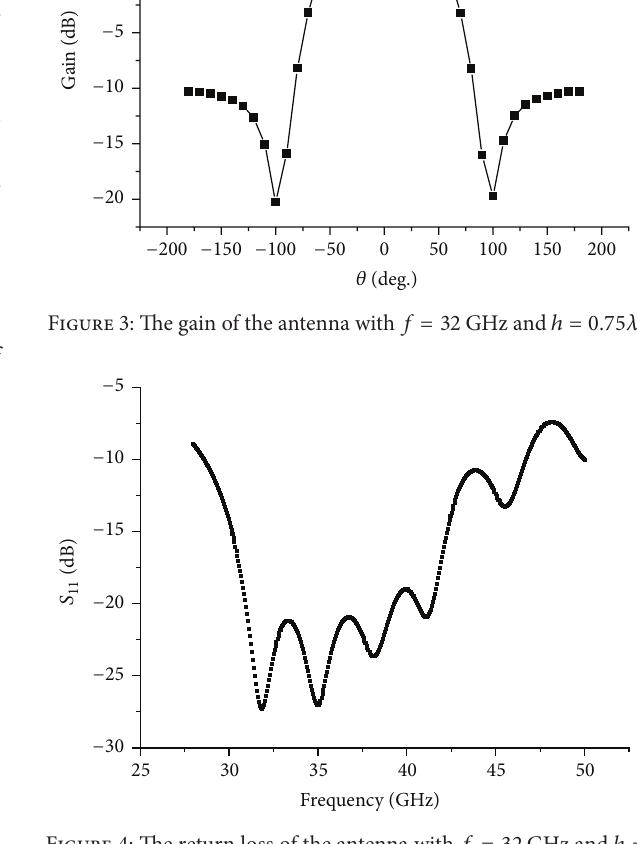
Figure 4: The return loss of the antenna with 𝑓 = 32 GHz and ℎ = 0.75𝜆